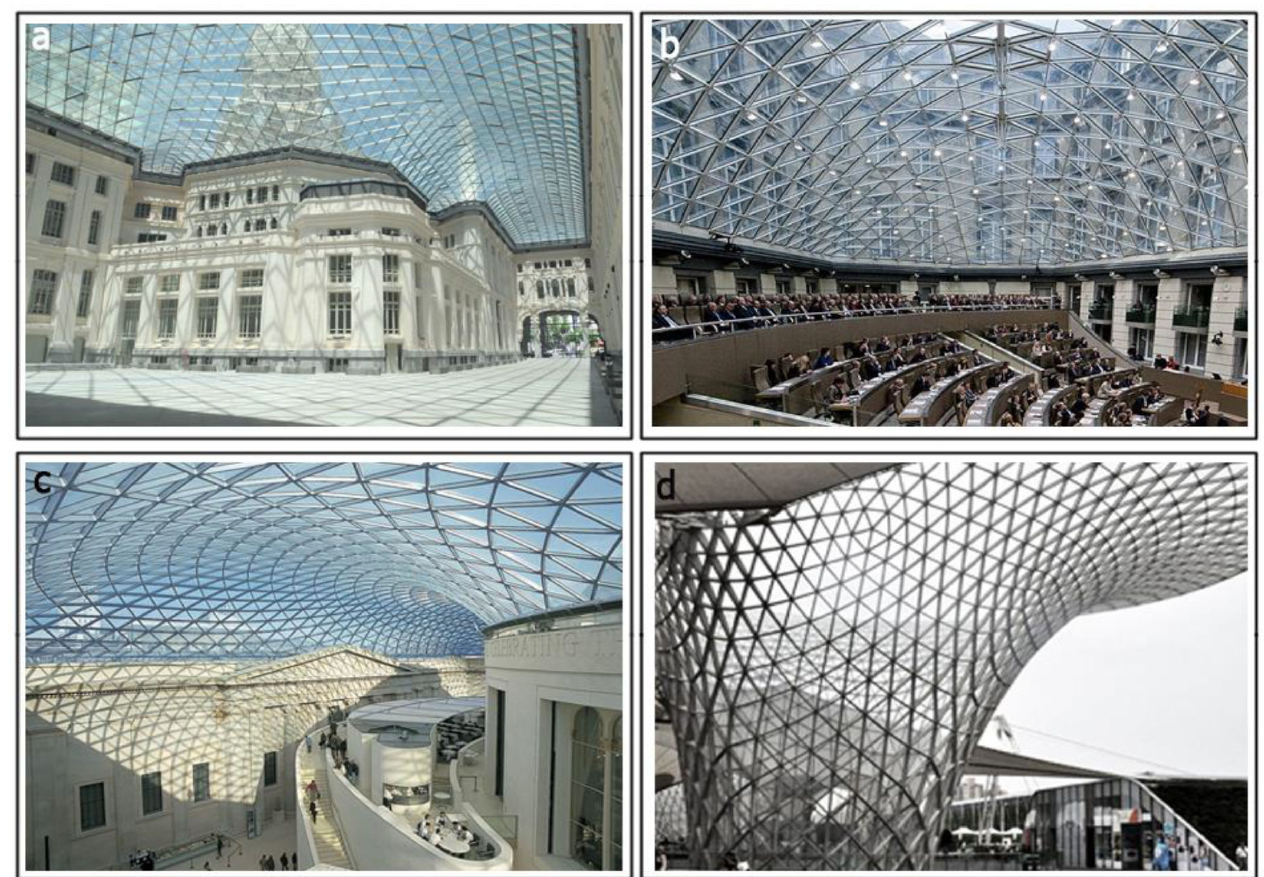
Figure 1. Curvilinear gridshell canopy with mesh triangular panelisation: ( a ) Madrid City Hall; ( b ) Meeting Hall Flemish Council in Belgium; ( c ) British Museum of Art; ( d ) Shanghai EXPO